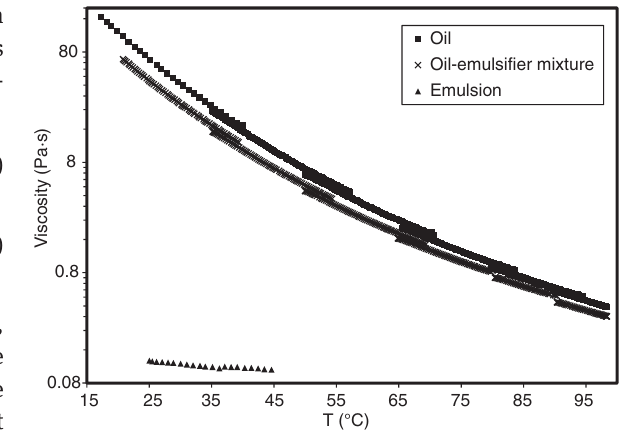
Figure 2 Viscosities of Oil, Oil-emulsifier mixture and emulsion as a function of temperature (at 10 s -1